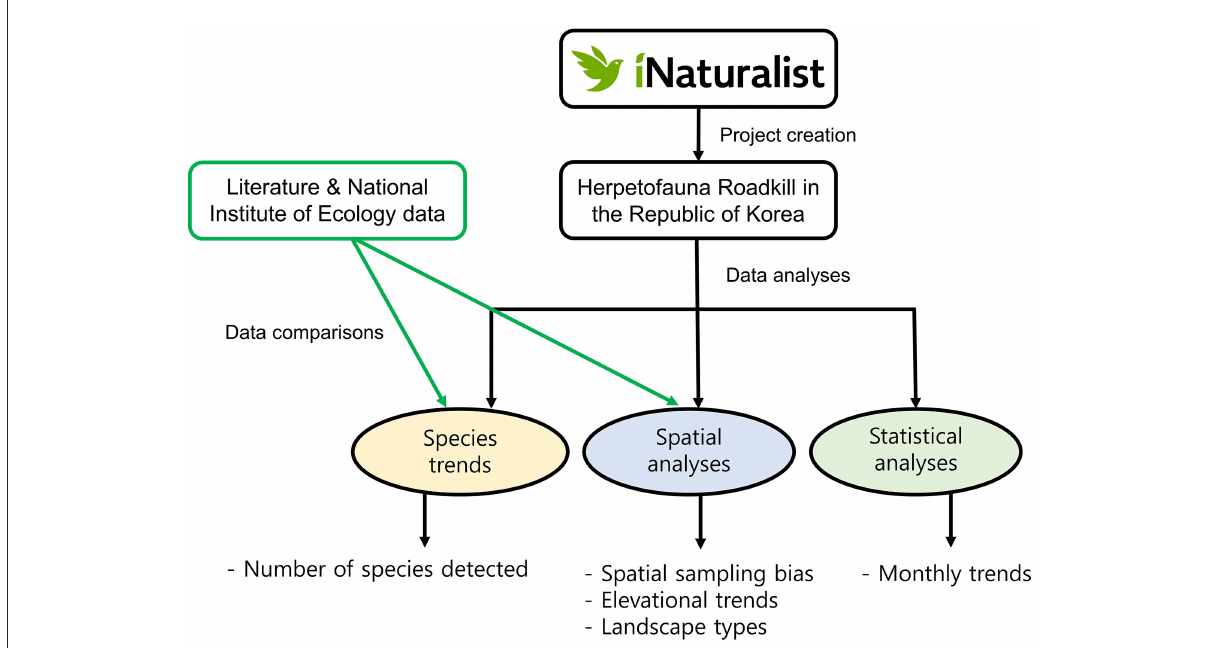
FIGURE1 Flow chart of data analyses on the roadkill dataset collected through iNaturalist. The project can be retrieved at: https://www.inaturalist.org/ projects/herpetofauna-roadkill-in-the-republic-of-korea.